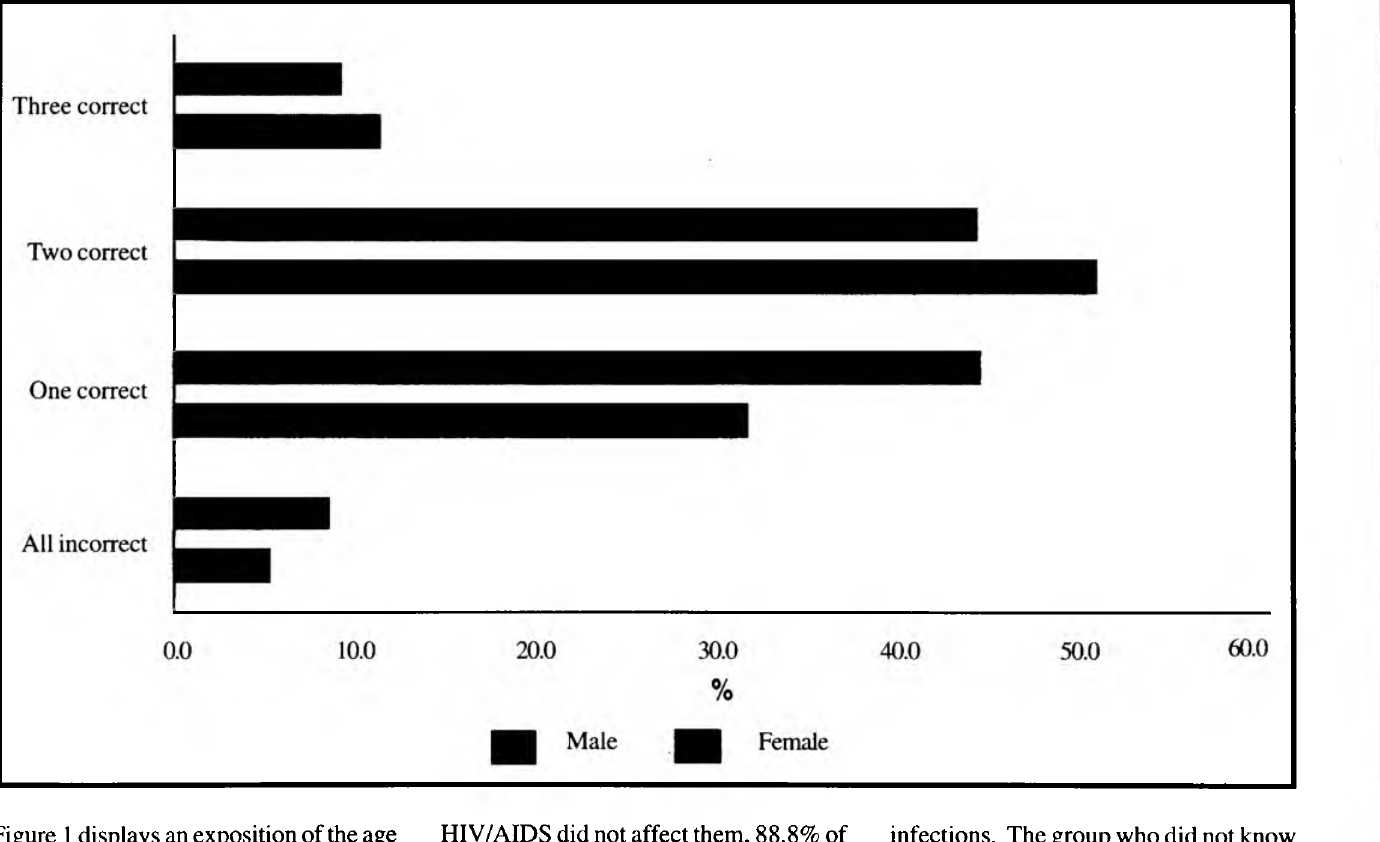
FIGURE 2: Percentage of correct responses regarding different sexually transmitted infections